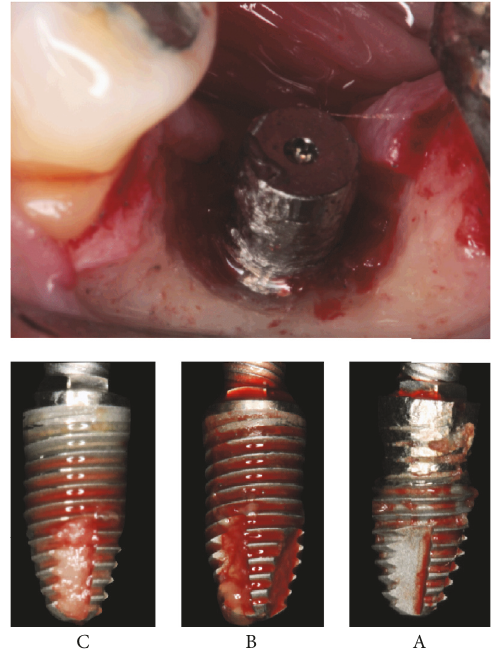
Figure 2: Peri-implantitis treatment. A: implantoplasty, B: acid treatment, and C: